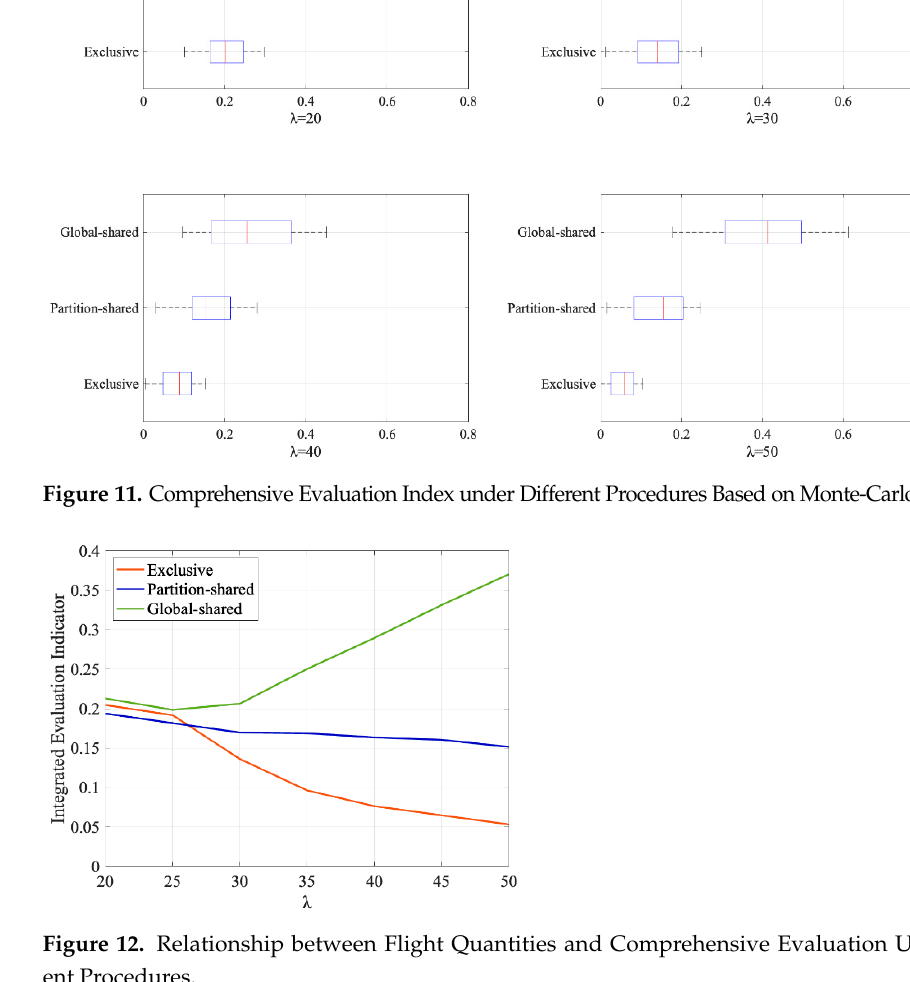
Figure 12. Relationship between Flight Quantities and Comprehensive Evaluation Using Different Procedures. ent